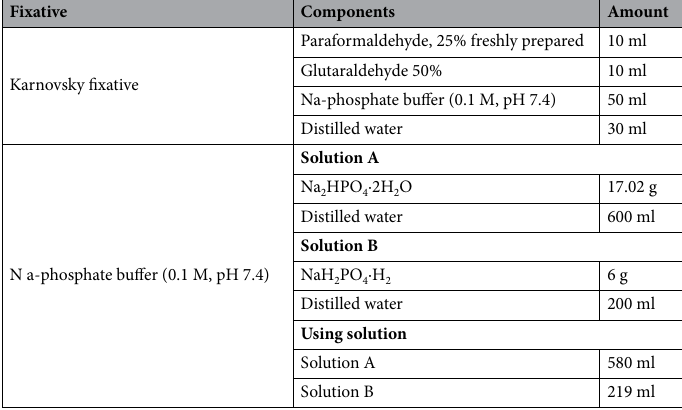
Table 1. Components of the Karnovsky fixative sand phosphate buffer.